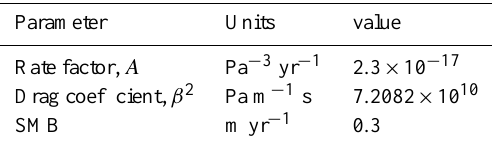
Table 2. Model inputs and parameter